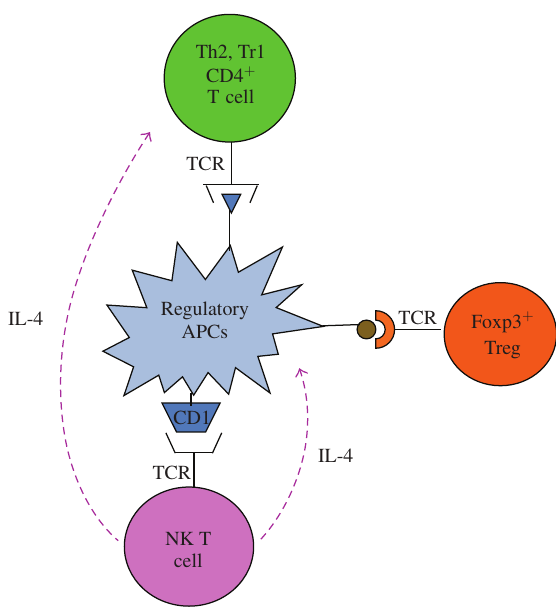
FIGURE 1: Model for host-donor immunoregulation after nonmyeloablative BMT. Figure illustrating key regulatory populations in host and donor and the potential for interactive regulation across major and minor histocompatibility complex barriers after allogeneic BMT. NKT cells, through potent of cytokines secretion including IL-4, can directly regulate the effector T cells responsible for GVHD; NKT cells can also induce the activation and proliferation of Treg from the donor graft, which in turn regulate effector T- cell-mediated GVHD. NKT: natural killer T; Th2: T-helper type 2; Tr1: Foxp3 neg CD4 + IL-10 + regulatory T cell; IL-4: